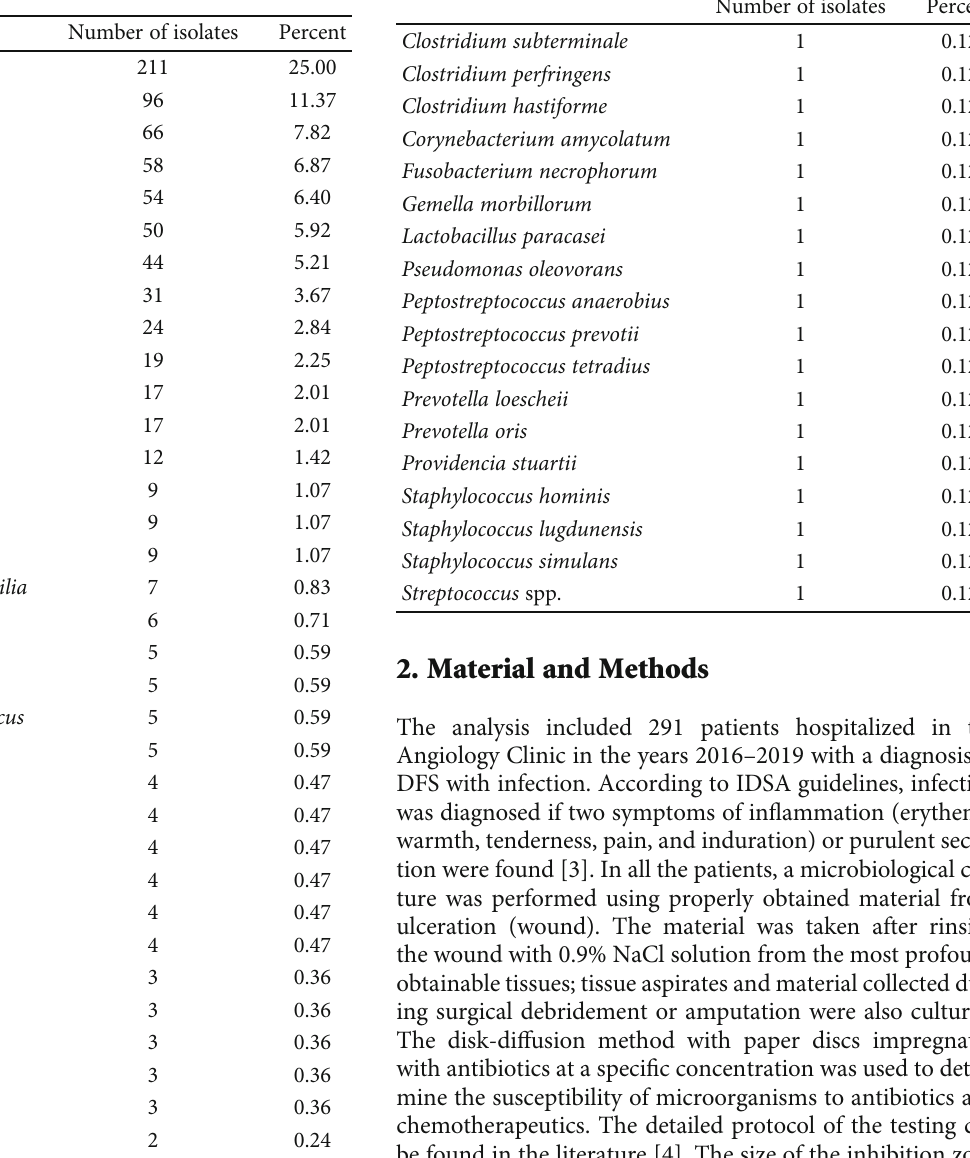
Table 1: Number of particular bacterial isolates in all patients with diabetic foot